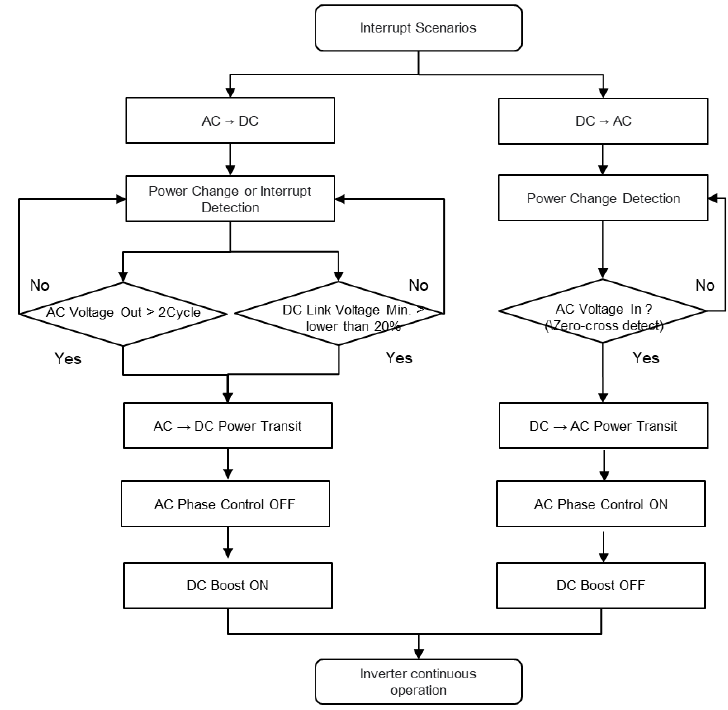
Figure 6. Flowchart showing the voltage interrupt scenarios.